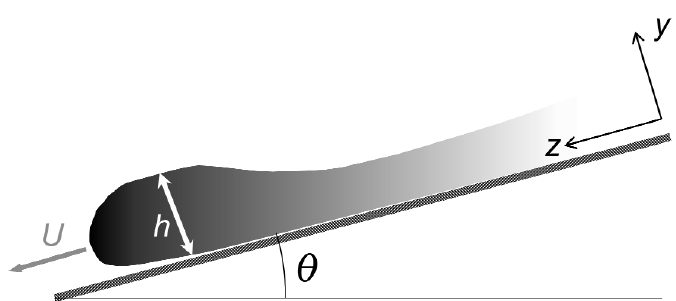
Fig. 1. Outline of a pyroclastic density